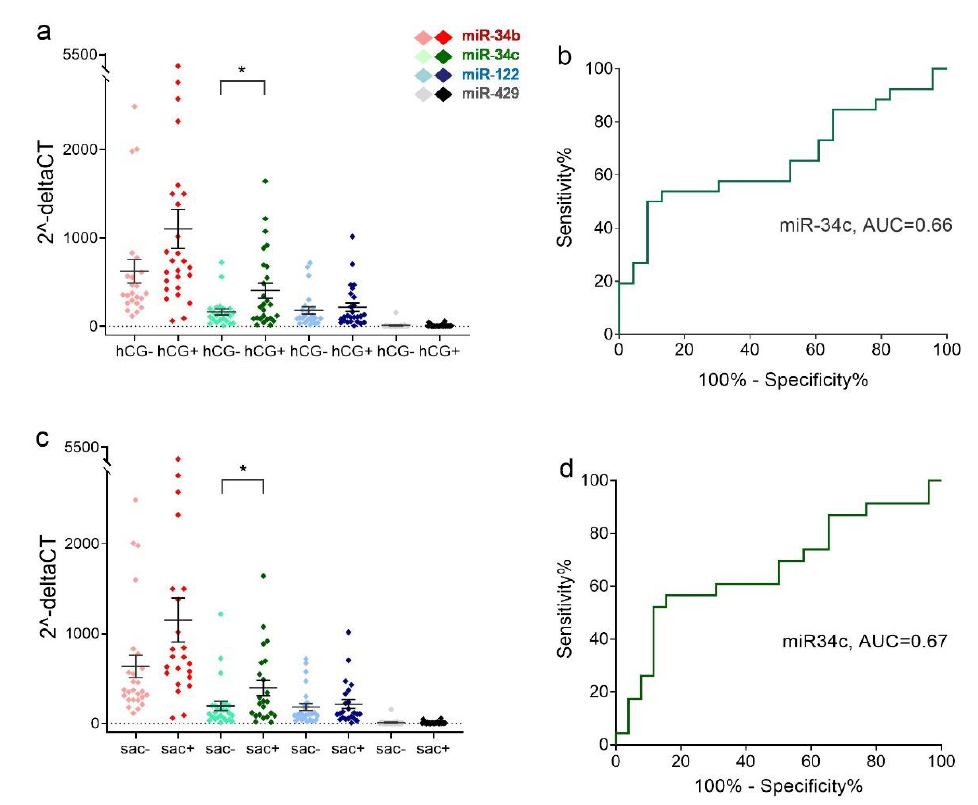
Figure 4. Relative expression levels of miR-34b and miR-34c in spermatozoa of teratozoospermia patients in clinical pregnancy and non-pregnant groups. ( a ) The scatter plot shows microRNA relative levels in each patient with or without urine hCG. ( b ) ROC curve analysis of miR-34c. ( c ) The scatter plot shows microRNA relative levels in each patient with or without a gestational sac under ultrasound detection. ( d ) ROC analysis curve of miR-34b. AUC denotes the area under the curve. The data are shown as mean and SEM. * p < 0.05.